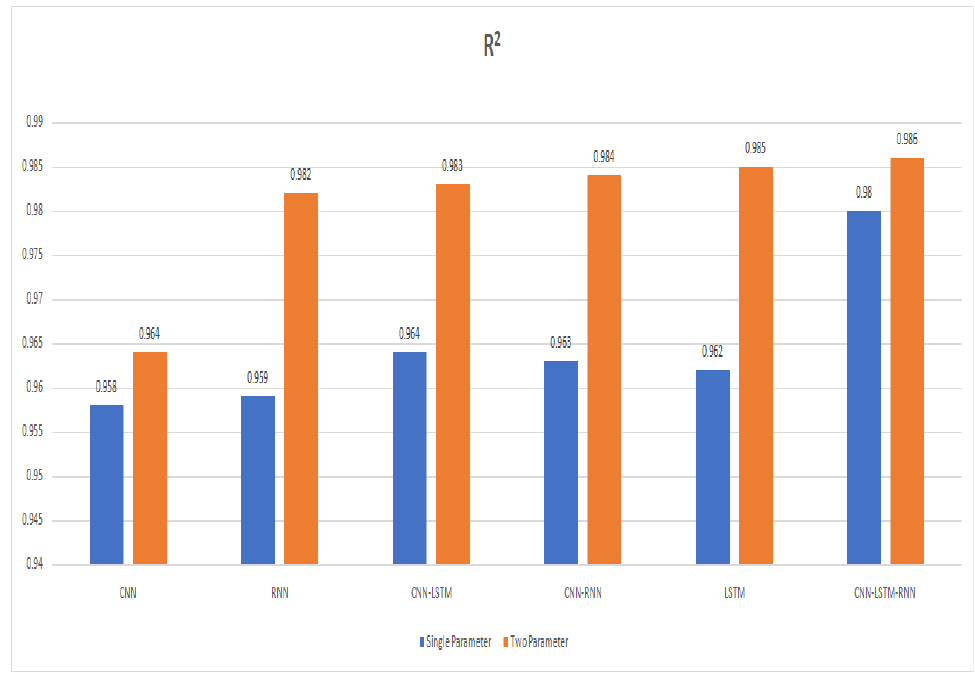
Figure 22. R 2 Comparison of different models. Table 5. Performance evaluation of the suggested approach compared to current techniques.